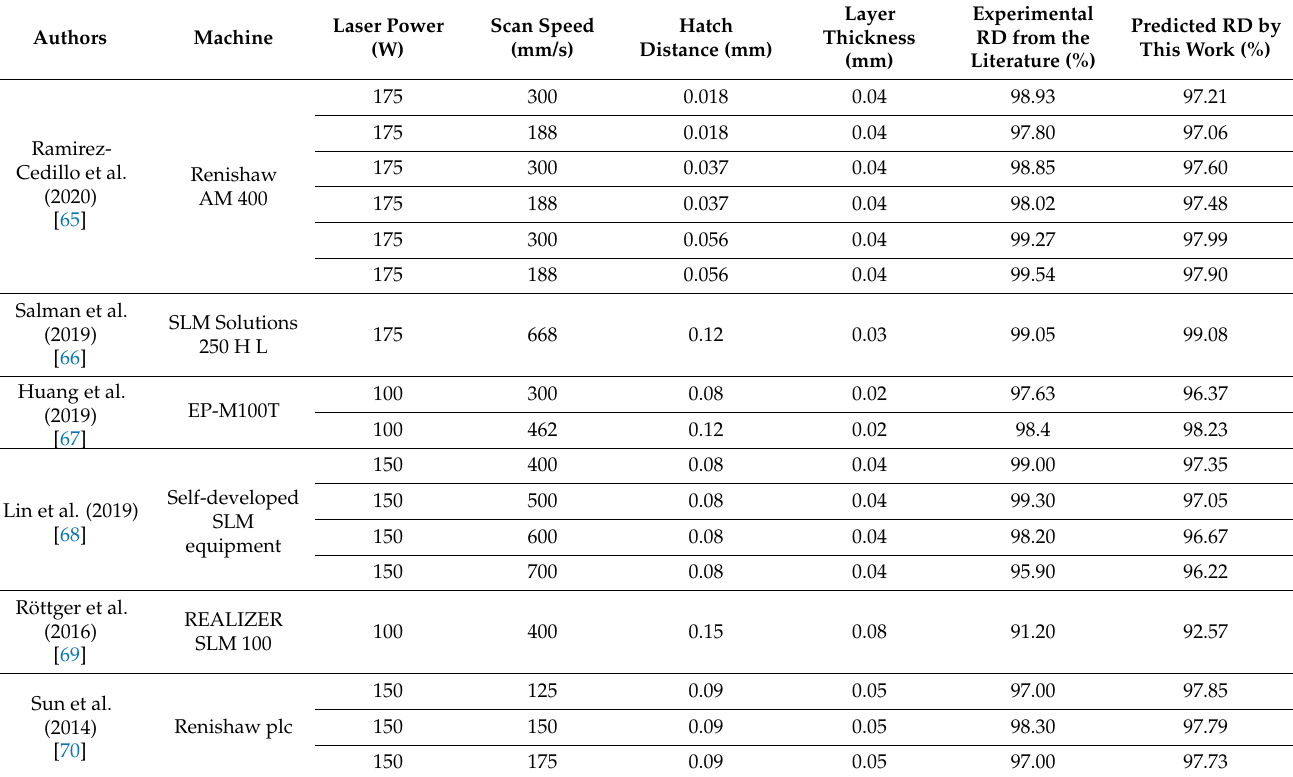
Table 10. Comparison of experimental (literature) and predicted (this work)